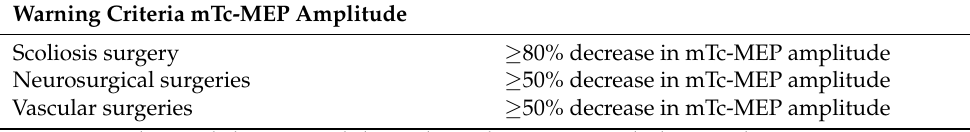
Table 1. mTc-MEP warning criteria. Warning Criteria mTc-MEP Amplitude Scoliosis surgery Neurosurgical surgeries Vascular